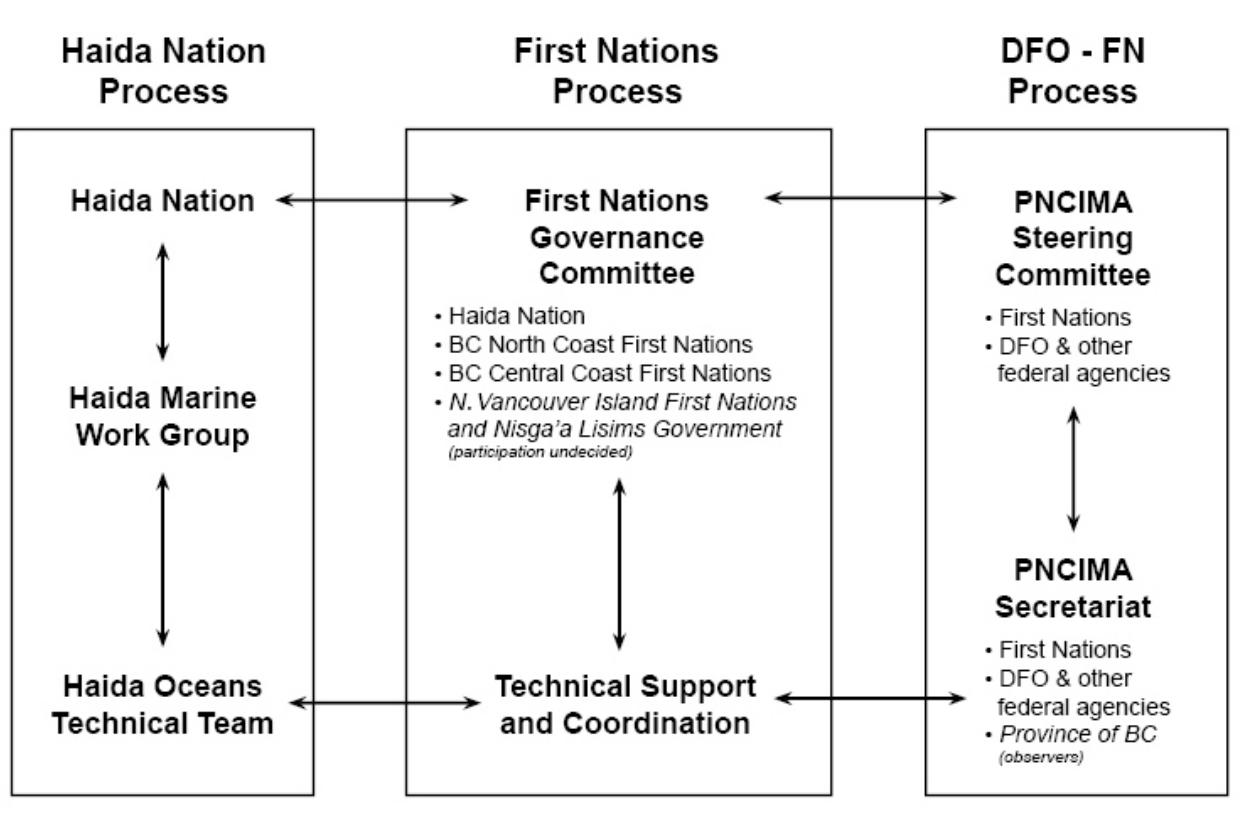
Fig. 4 . Marine-use planning process from the Haida perspective. First Nations is abbreviated here as FN, Fisheries and Oceans Canada as